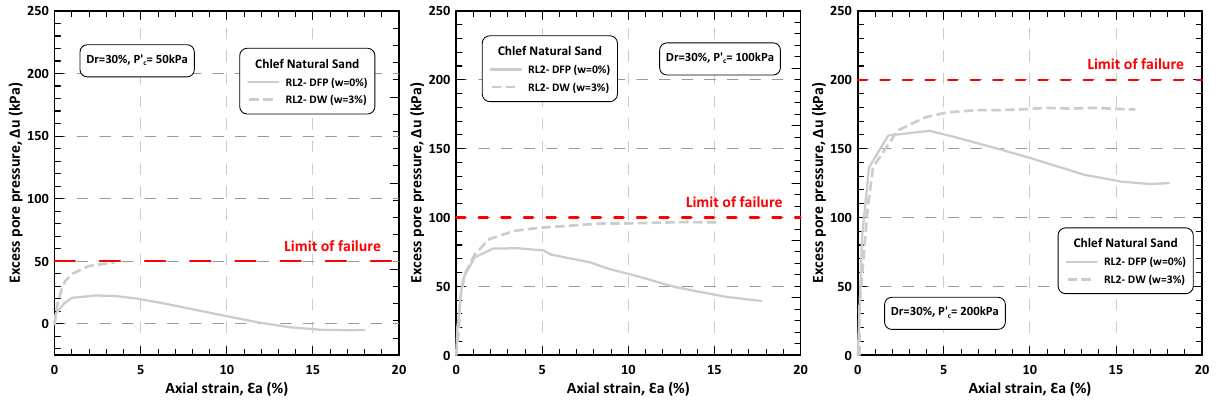
Fig. 11 Excess pore water pressure versus axial strain curves of sand reinforced with two layers of geotextile under different confining pres- sures: a p ′ = 50 kPa, b p ′ = 100 kPa, and c p ′ = 200 c c c